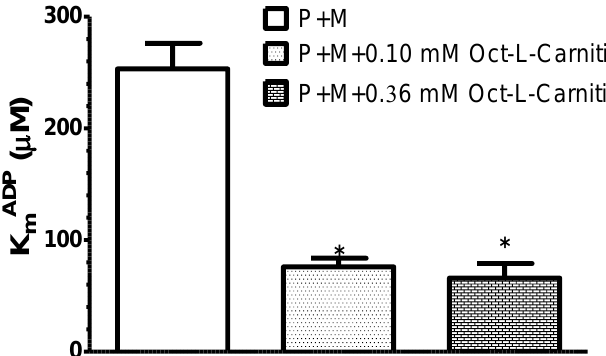
Figure 4. Influence of different respiratory substrates: pyruvate + malate (P + M, 6 mM + 6 mM), pyruvate + malate + octanoyl- L -carnitine (6 mM + 6 mM + 0.36 mM) and pyruvate + malate + octanoyl- L -carnitine (6 mM + 6 mM + 0.1 mM) on the apparent K mADP of saponin-permeabilized rat cardiac fibers. In this case, n = 4; 37 ◦ C; * p < 0.05 vs. control (pyruvate + malate). The results were analyzed with one-way analysis of variance (ANOVA) followed by the Dunnett post hoc test.